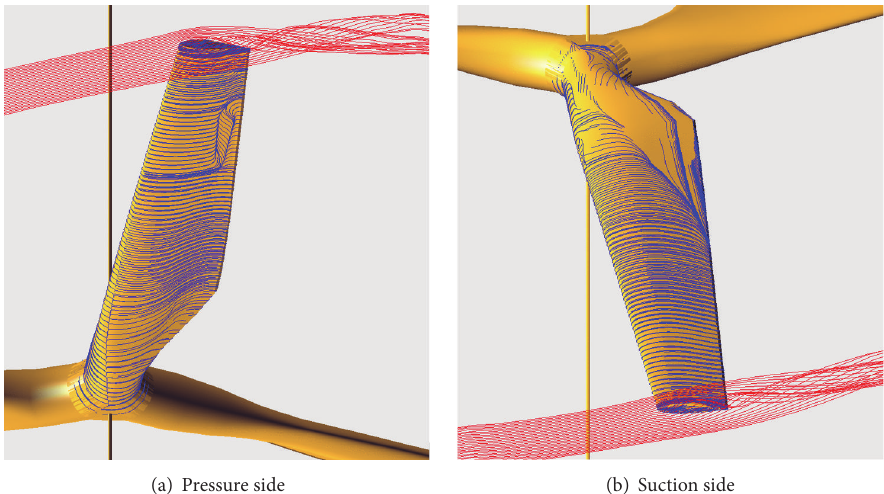
Figure 13: Limiting streamlines solved on blade surface by the steady 𝑘 - 𝜀 turbulence model for tip speed ratio 𝜆 = 5 .